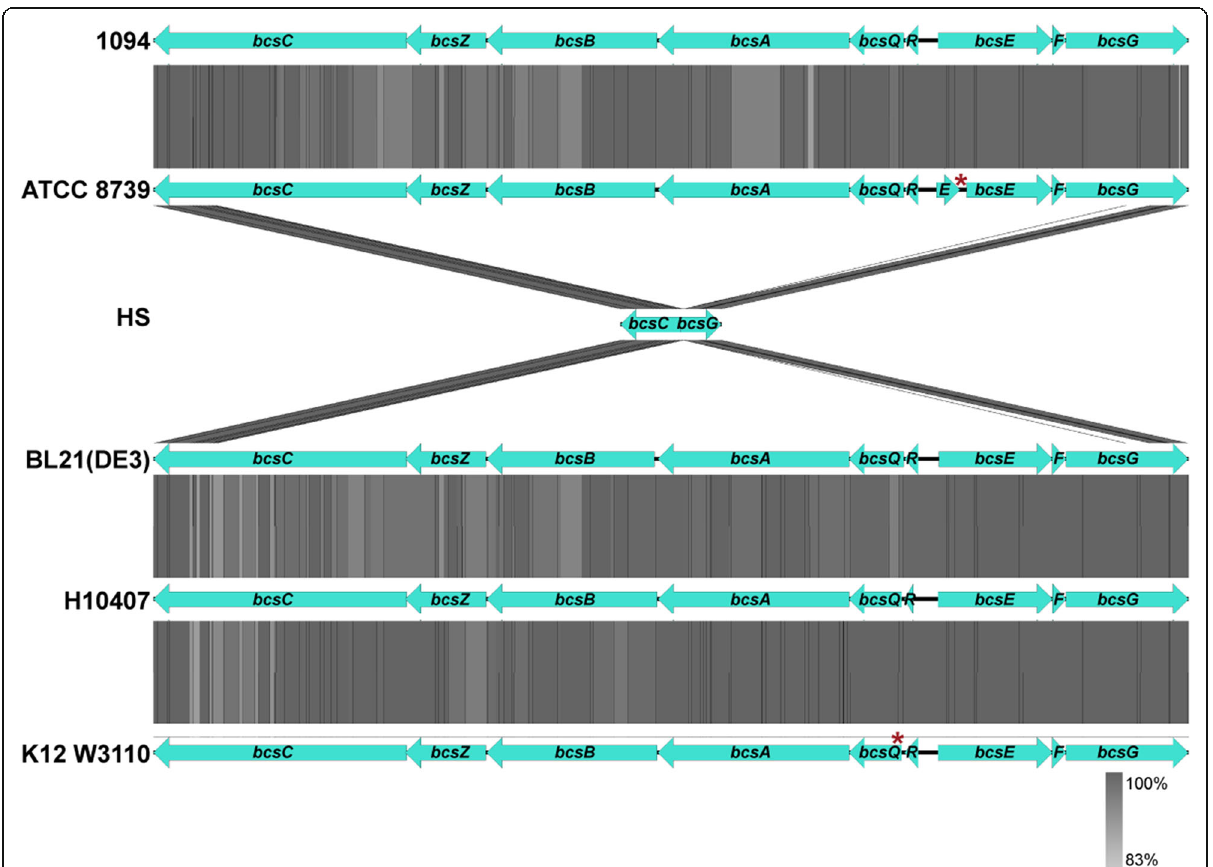
Fig. 5 Genomic organization and Blastx comparison of the bacterial cellulose synthesis ( bcs ) region in six E. coli strains. The name of the corresponding genes are indicated. The gray color code represents the pairwise Blast matches between one strain, and the strain directly below it; darkness corresponds to higher similarity between the two strains, and strains were ordered based on phylogenetic relatedness. The star in red represents a SNP leading to a premature stop codon. The figure was generated using the Easyfig software [41]